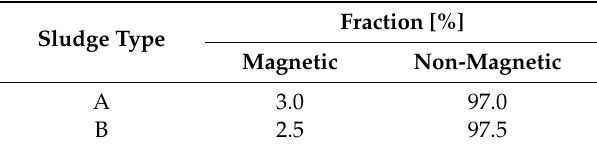
Table 6. Results of magnetic separation